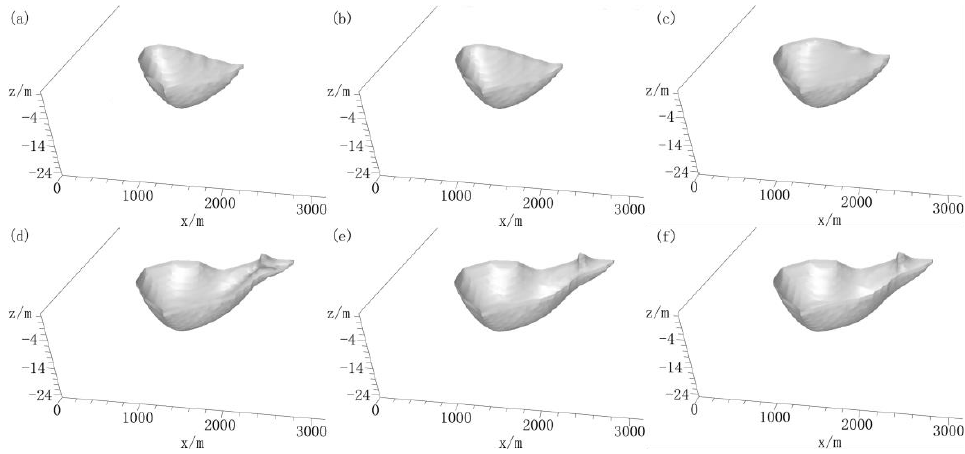
Figure 6. The freshwater lens formation process after island reclamation. The freshwater lens of initial island ( a ); freshwater lenses at 1, 5, 10, 15 and 25 years, respectively, after island reclamation ( b – f